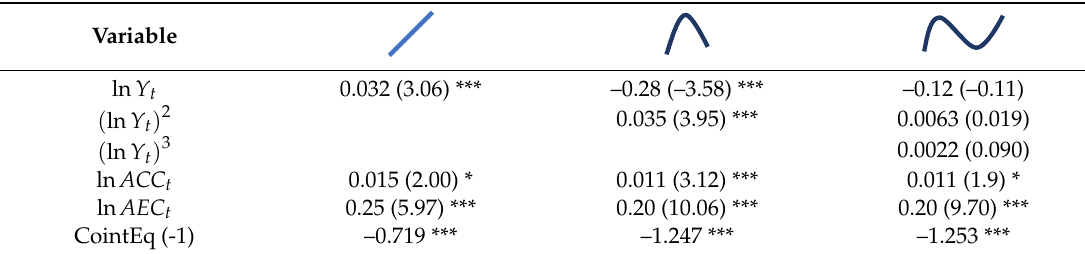
Table 7. Error correction model and long-run relationship. Table 6. Bounds test and short ‐ run relationship. Table 9. Residual diagnostic tests.